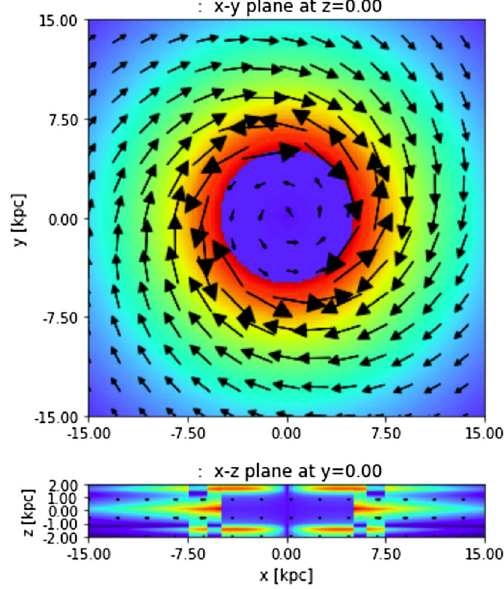
Fig. 4 Schematic picture of the magnetic field in our model galaxy. B is measured in microgauss ( μ G) and x , y , z in kiloparsecs (Kpc)